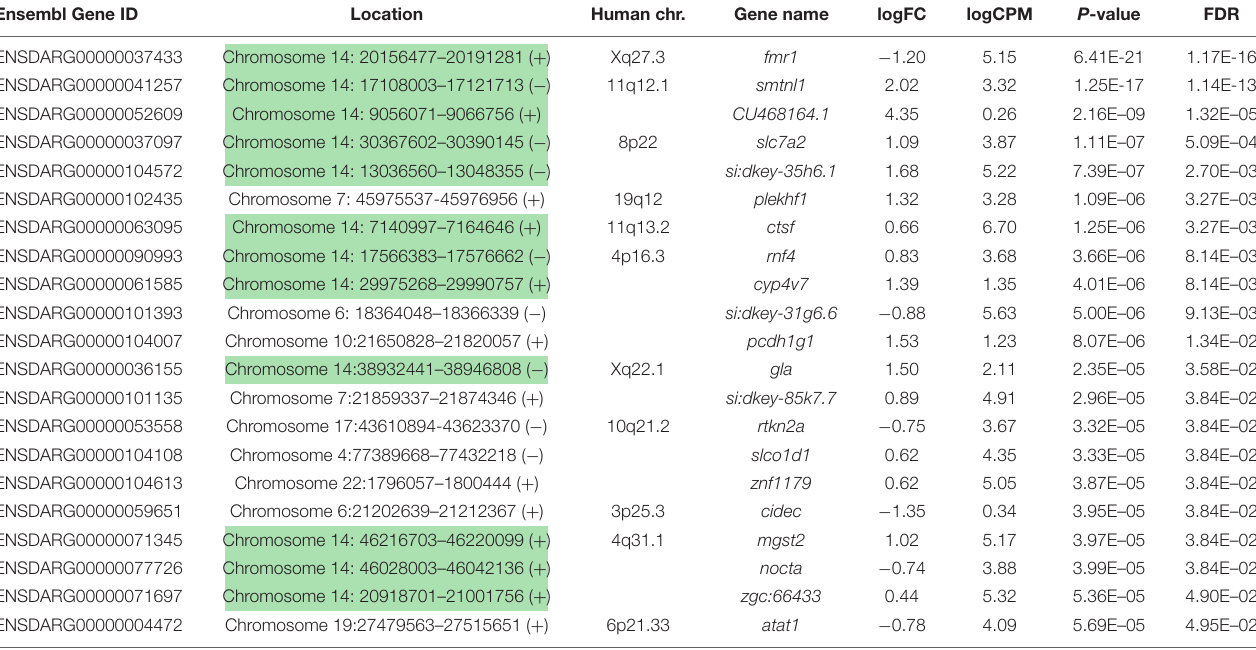
TABLE 1 | Genes differentially expressed in 2 dpf homozygous fmr1 hu 2787 embryos. Ensembl Gene ID Location Human